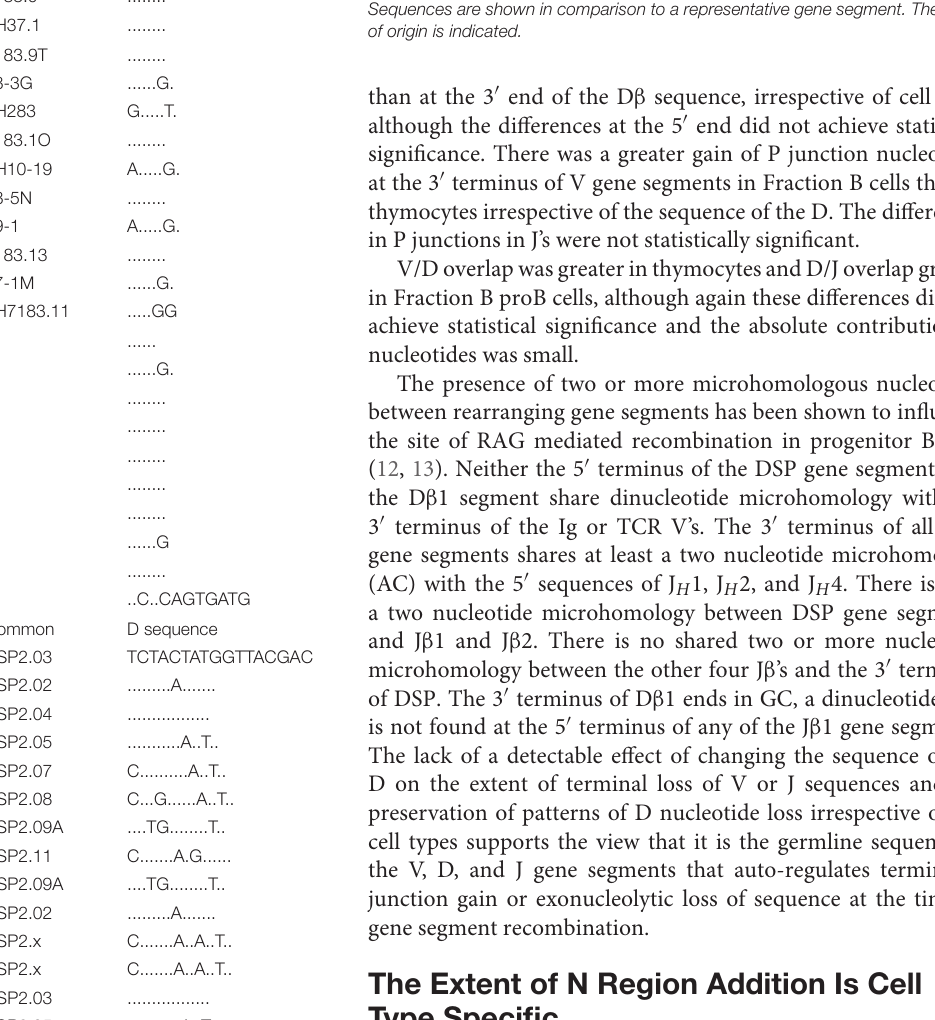
TTC...TAAT.CGCC.CTCTA.